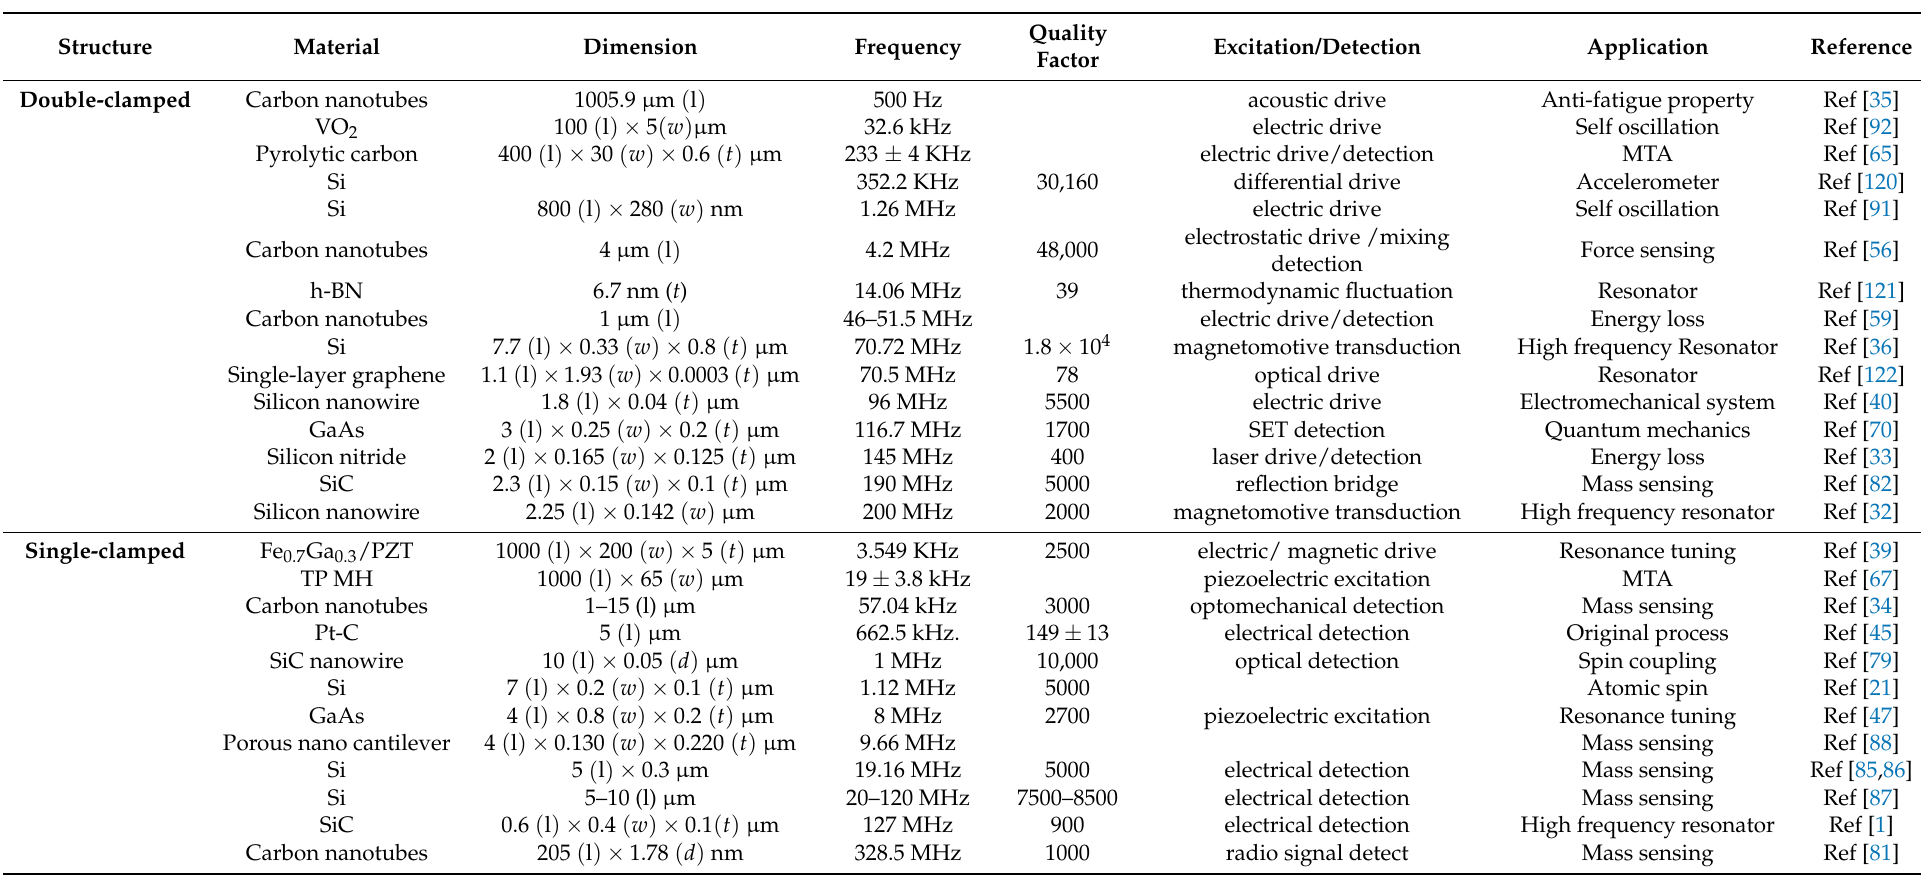
Table 1. Resonance performance, application, and excitation/detection methods of resonators with different